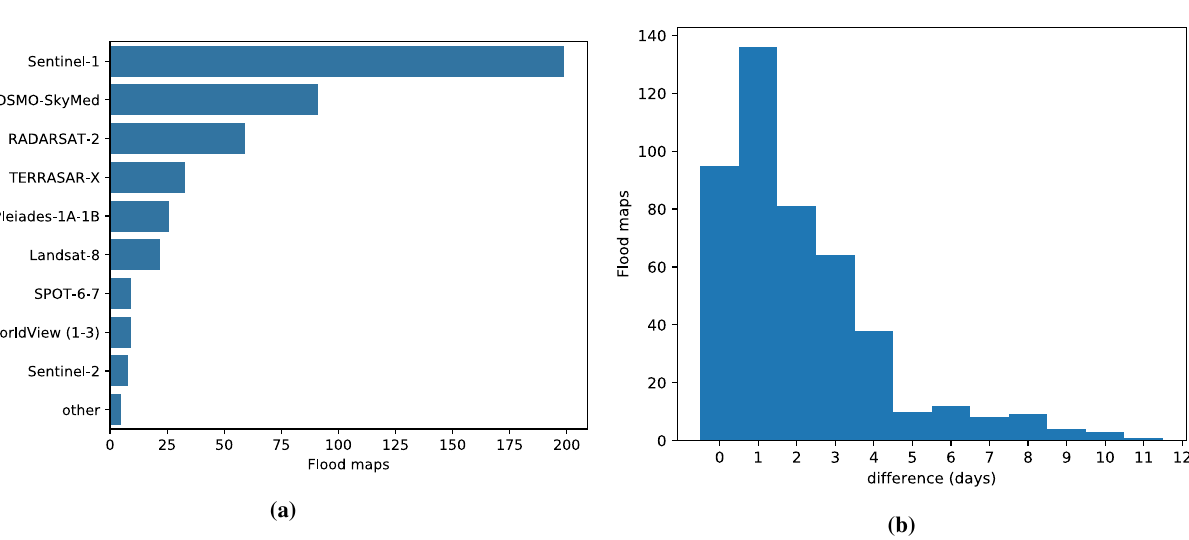
Figure 5. ( a ) Satellite used to derive each flood map in the WorldFloods data set. ‘Other’ satellites (all optical): GeoEye-1, PlanetScope, Earth Observing (EO)-1. ( b ) Difference in days between the flood map and the Sentinel-2 image (Sentinel-2 image is always posterior in time to the flood